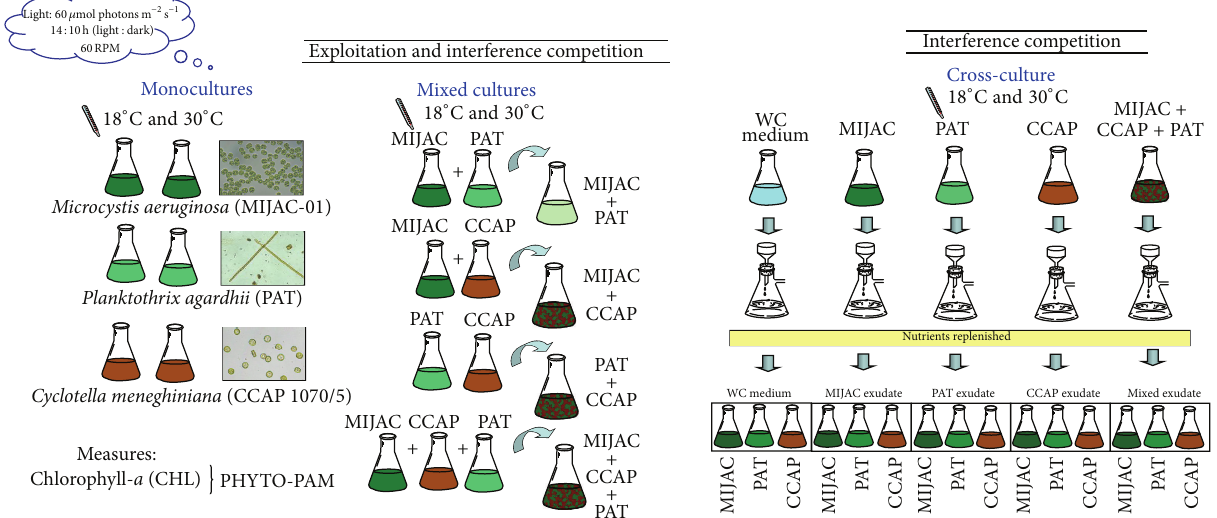
Figure 1: Experimental design of temperature effect on monoculture growth and direct and indirect competition among Microcystis aeruginosa , Planktothrix agardhii , and Cyclotella meneghiniana.